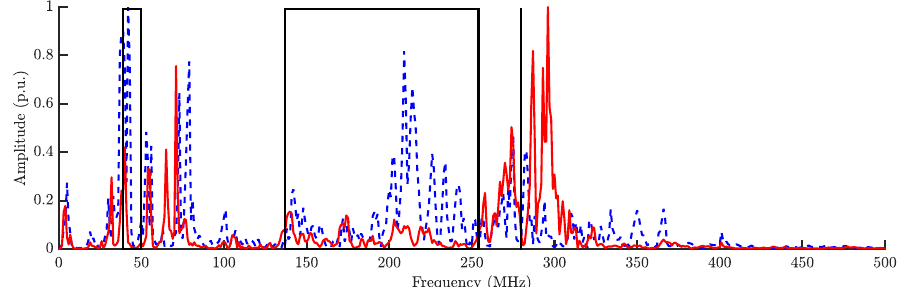
Figure 8. Average power spectral density of the signals captured by the antenna 1 and the selected intervals that maximize the distance between clusters in the PR map. The solid line corresponds to dark cluster and the dashed plot to the grey cluster.